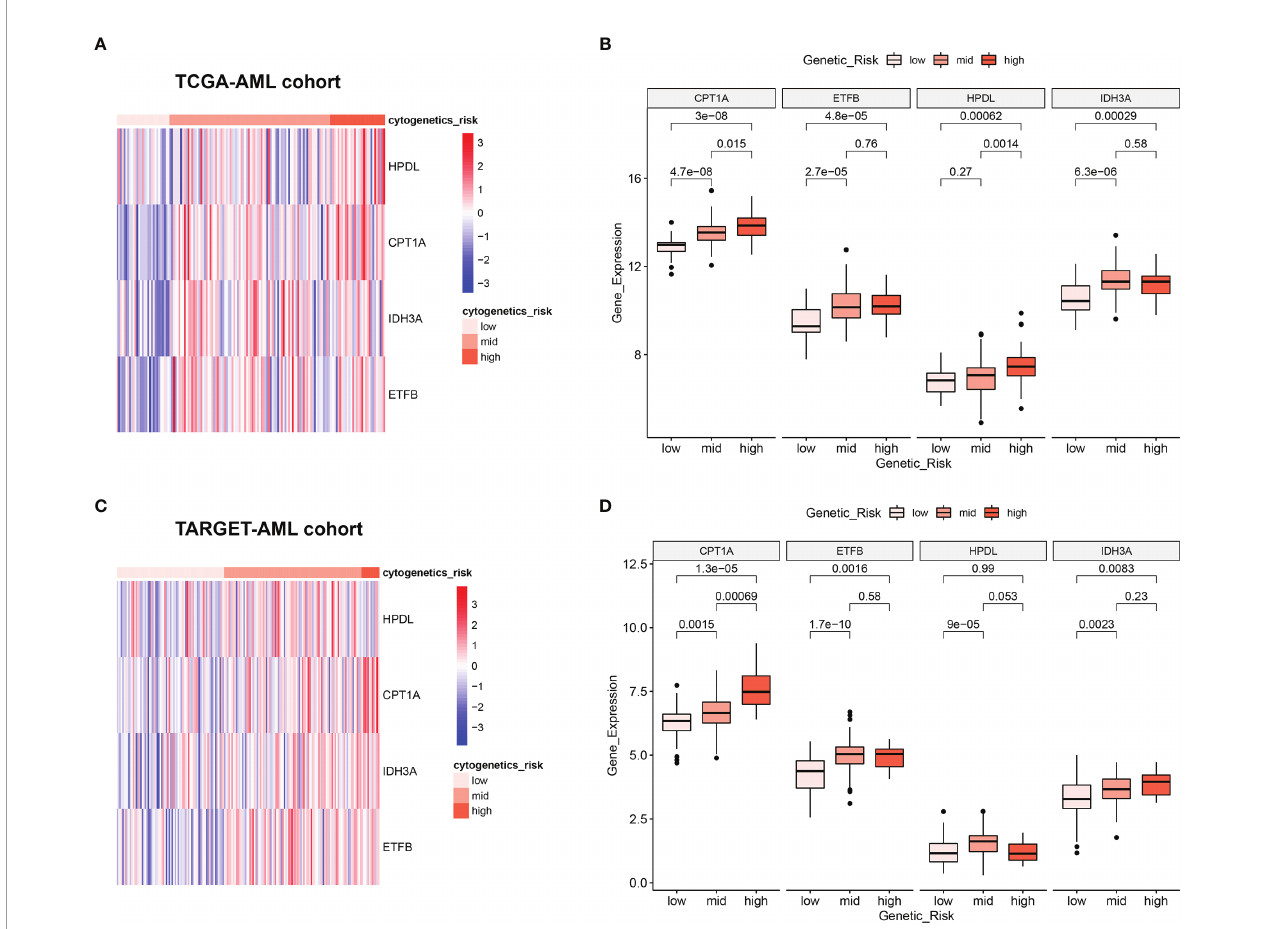
FIGURE 4 | Relationship between 4 MRGs ’ expression and cytogenetic risk in AML. (A) The heatmap of 4 MRGs in different risk strati fi cation in TCGA-AML. (B) The boxplot of the 4 MRGs in different risk strati fi cation in TCGA-AML. (C) The heatmap of 4 MRGs in different risk strati fi cation in TARGET-AML. (D) The boxplot of the 4 MRGs in different risk strati fi cation in TARGET-AML cohort. AML, acute myeloid